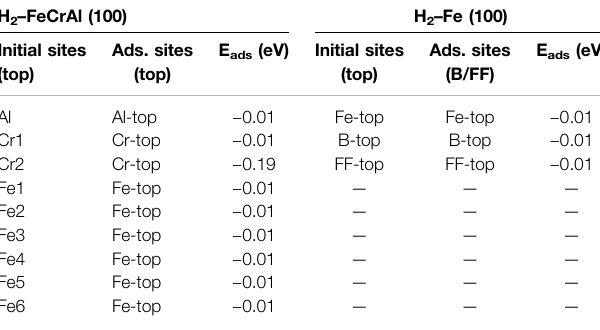
TABLE 2 | Adsorption energies of the H 2 molecule on the Fe (100) and FeCrAl (100)